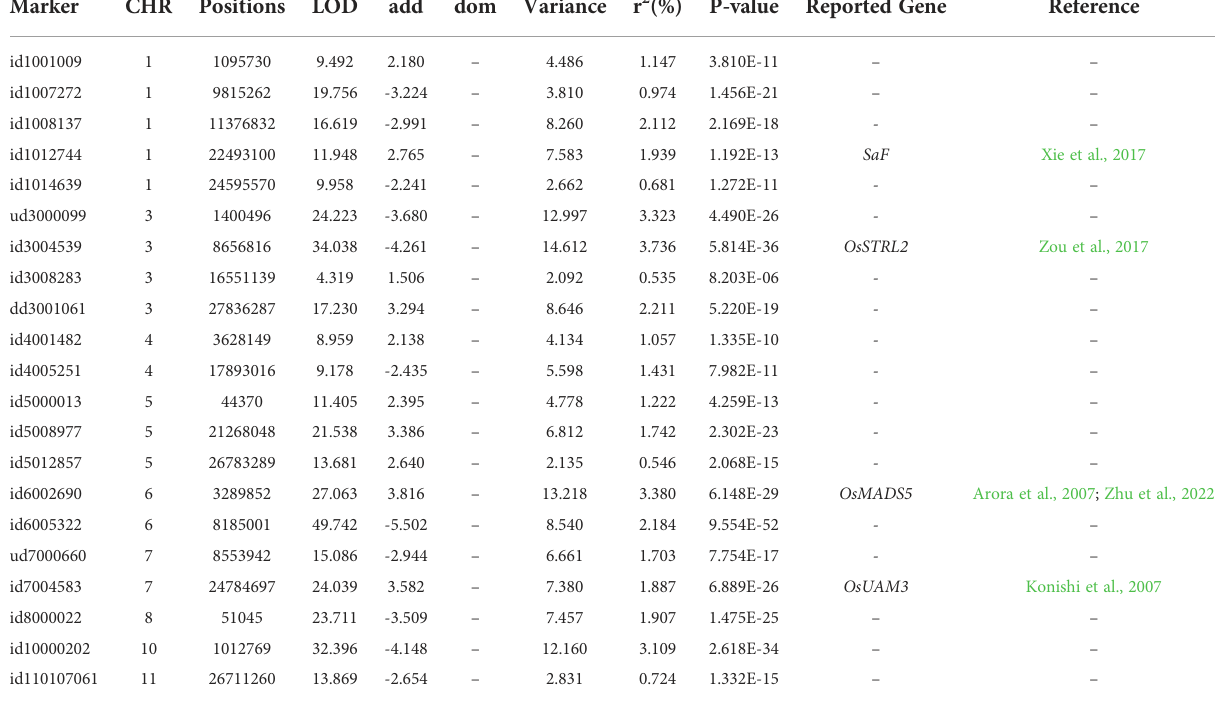
TABLE 3 Signi fi cant/suggestedQTNsfor rice fl